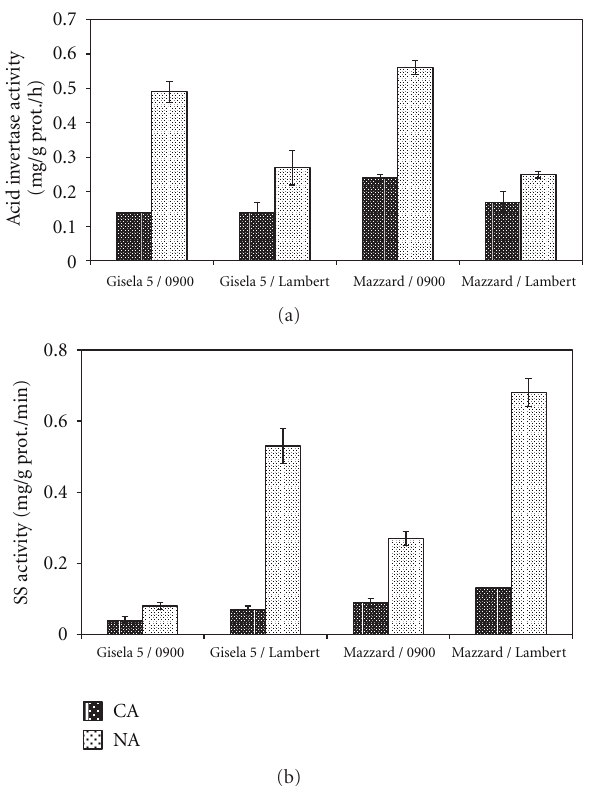
Figure 3: Acid invertase (a) and SS (b) activities in cold-acclimated (CA, in January) and nonacclimated (NA, in July) bark tissues of sweet cherry cultivars grafted on di ff erent rootstock. Error bars represent ± SE of three